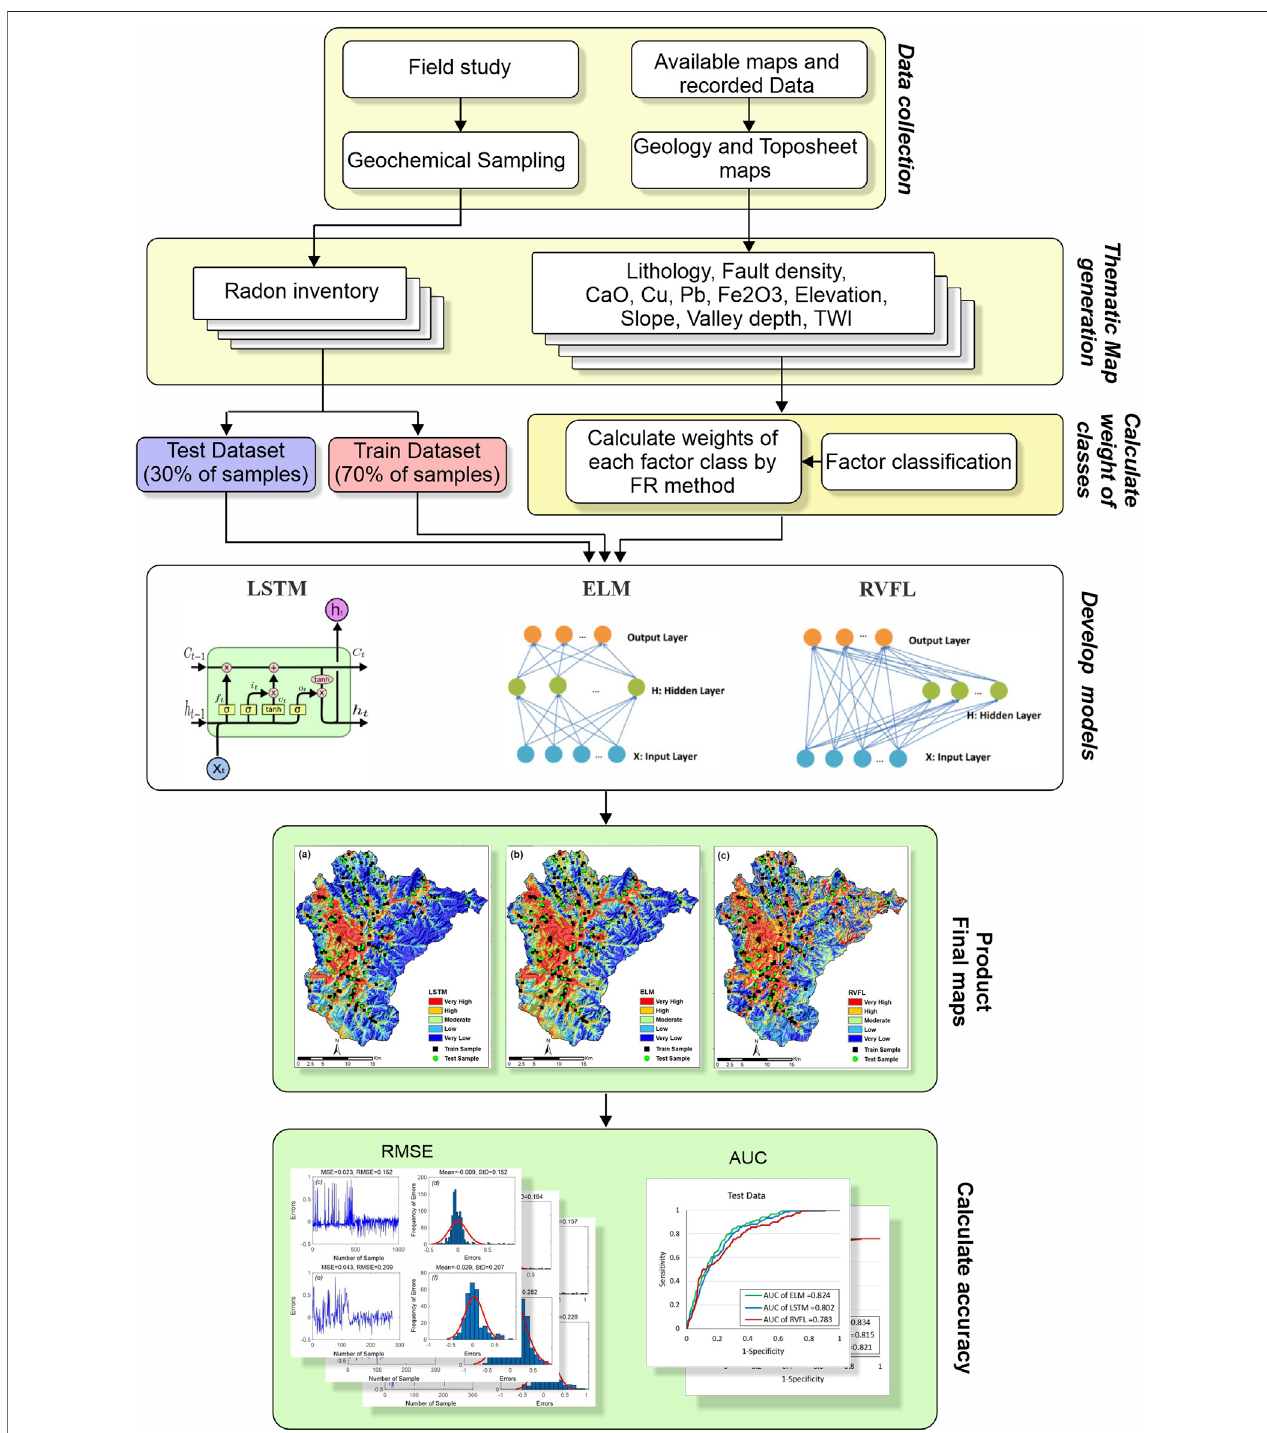
FIGURE 4 | Flowchart of the method used to map indoor radon